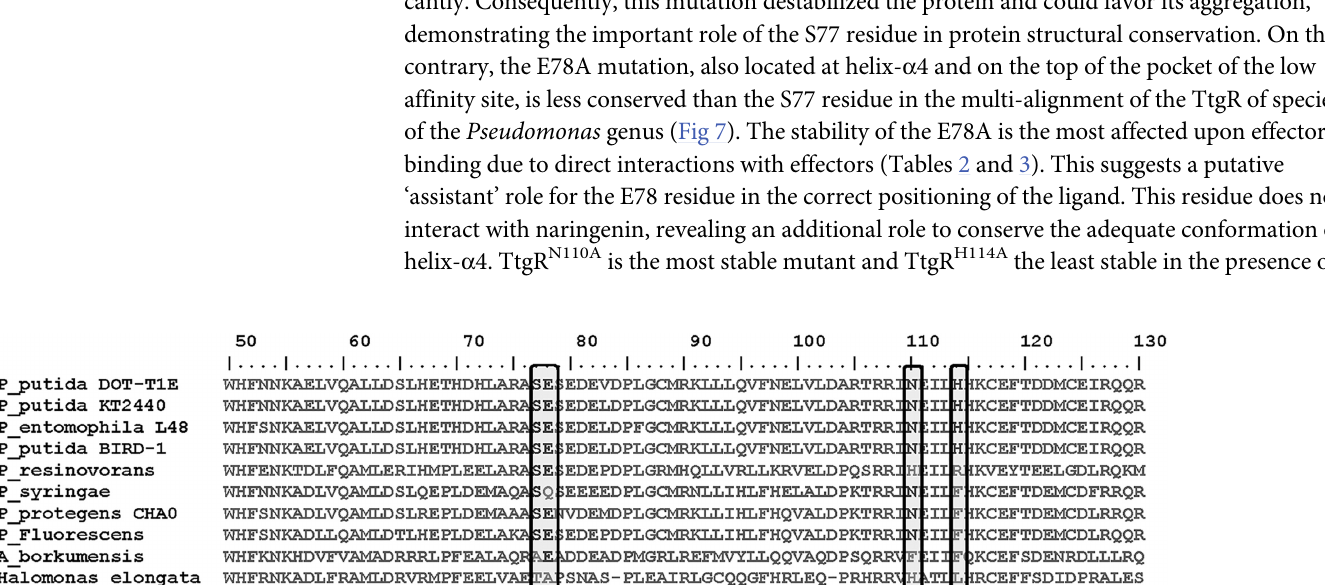
PLOS ONE | DOI:10.1371/journal.pone.0138469 September 30,